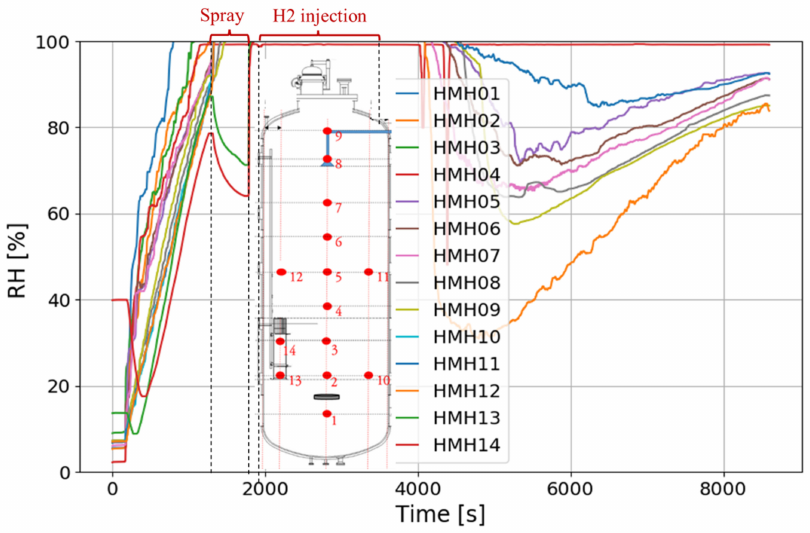
Figure 11. Time variations in the relative humidity measured during the SSP3